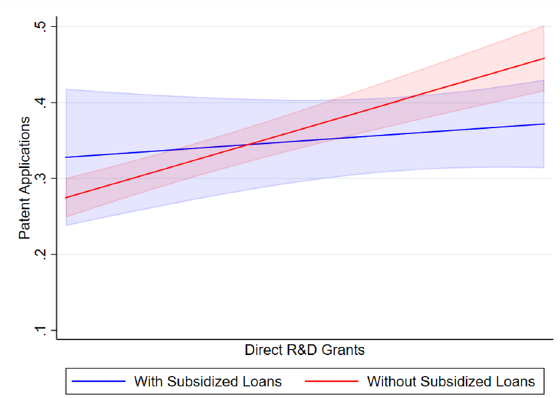
Figure 1. The effects of R&D subsidies on exploratory patent applications